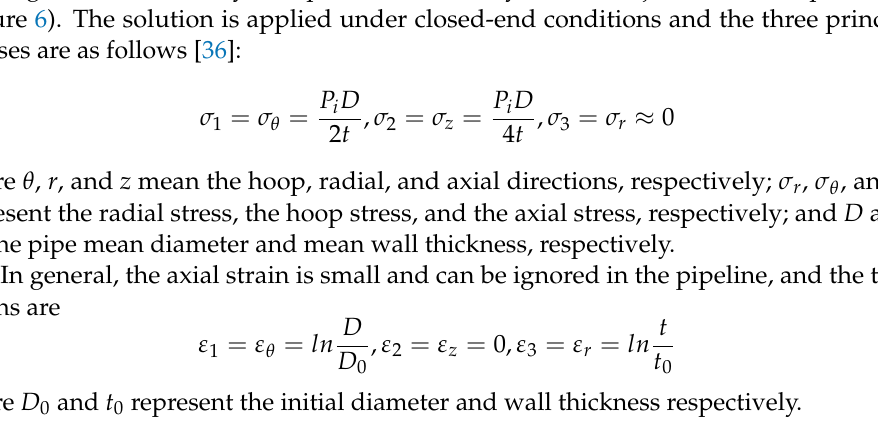
Figure 6. The force and deformation of the cylindrical unit under internal pressure. 𝜎 (cid:2869) = 𝜎 (cid:3087) = 𝑃 (cid:3036) 𝐷 2𝑡 , 𝜎 (cid:2870) = 𝜎 (cid:3053) = 𝑃 (cid:3036) 𝐷 4𝑡 , 𝜎 (cid:2871) = 𝜎 (cid:3045) ≈ 0